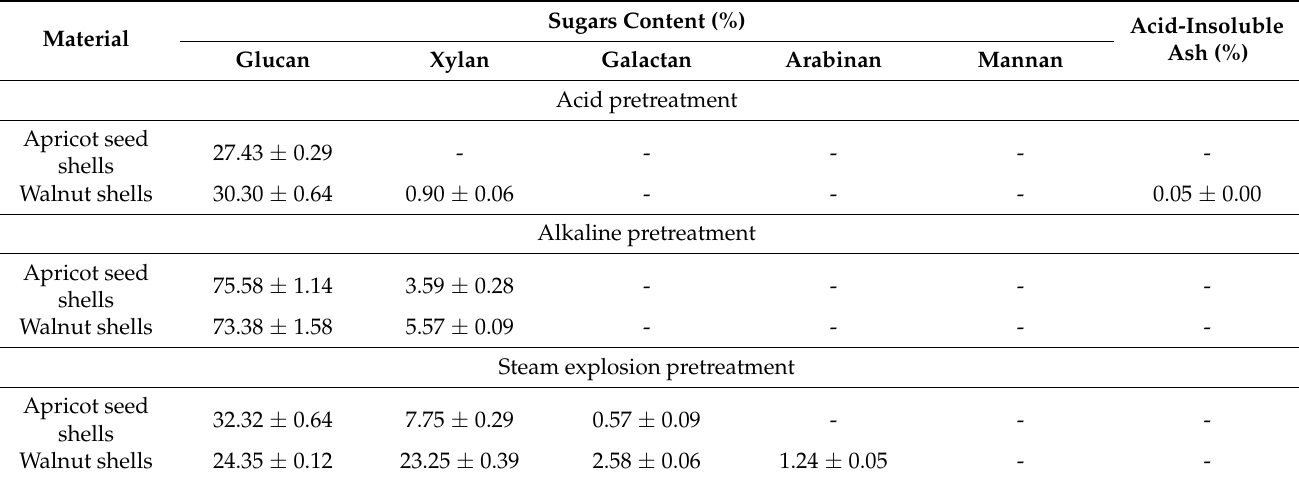
Table 2. Solid characterization after acid, alkaline, and steam explosion pretreatment of